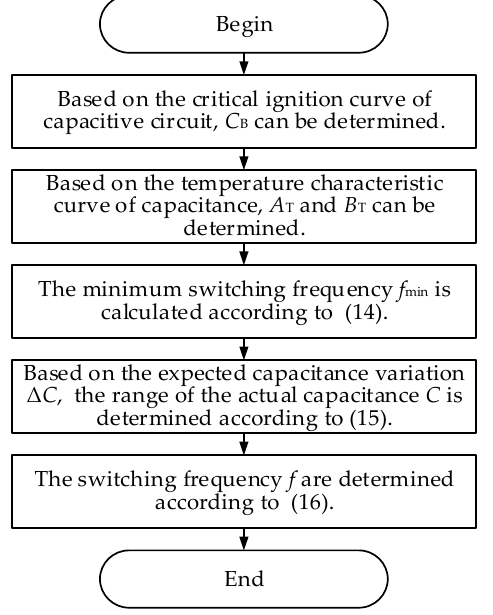
Figure 4. Proposed design method of an intrinsically safe Buck converter.